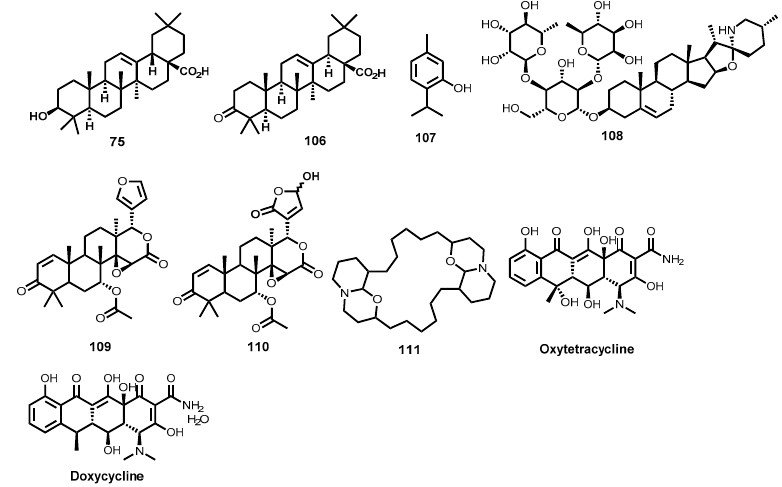
Figure 20. Naturally derived antifilarial compounds.